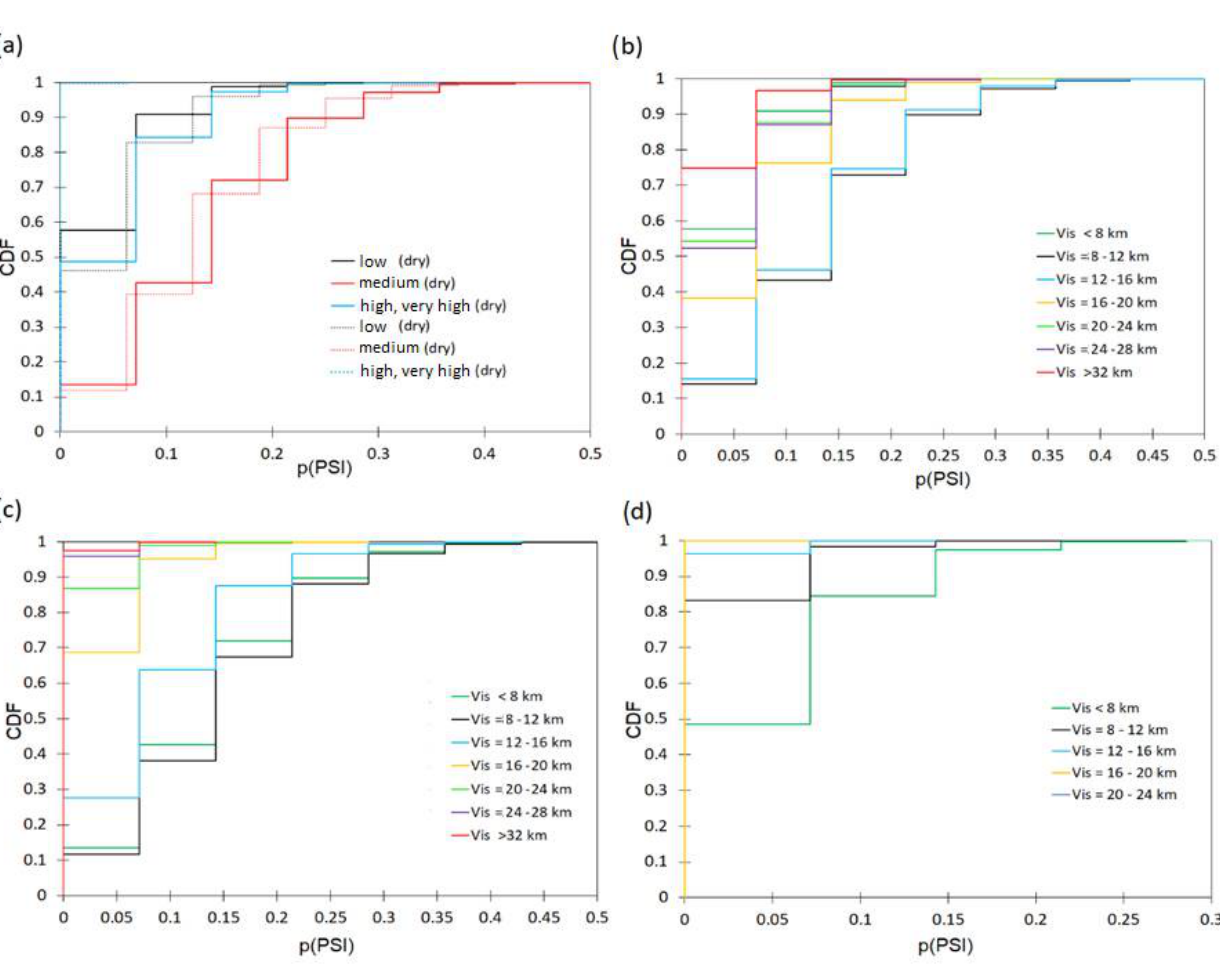
Figure 8. Effect of rainfall conditions on the incidence of winter mortality risk for Vis < 8 km. Effect of visibility on the incidence of mortality risk: ( a ) low; ( b ) medium; ( c ) high; ( d ) very high for the dry period.